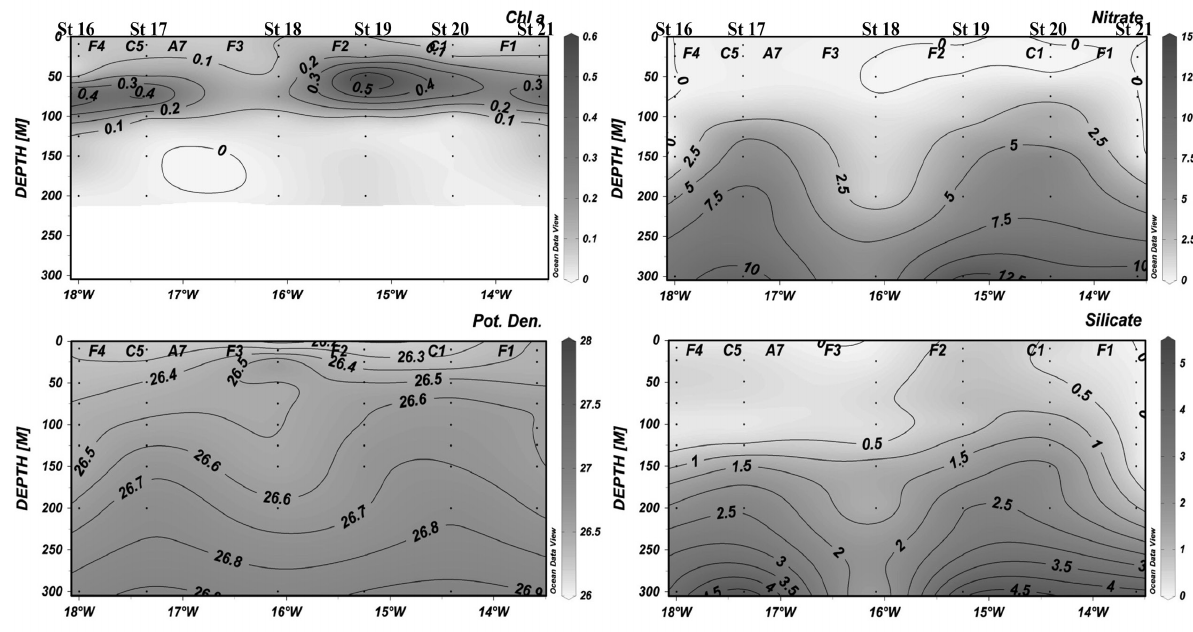
Fig . 4. – Chlorophyll a (mg m -3 ), potential density (kg m -3 ), nitrate+nitrite (μmol kg -1 ) and silicate (μmol kg -1 ) in the upper 300 m along the oblique line 2, as indicated in Fig.